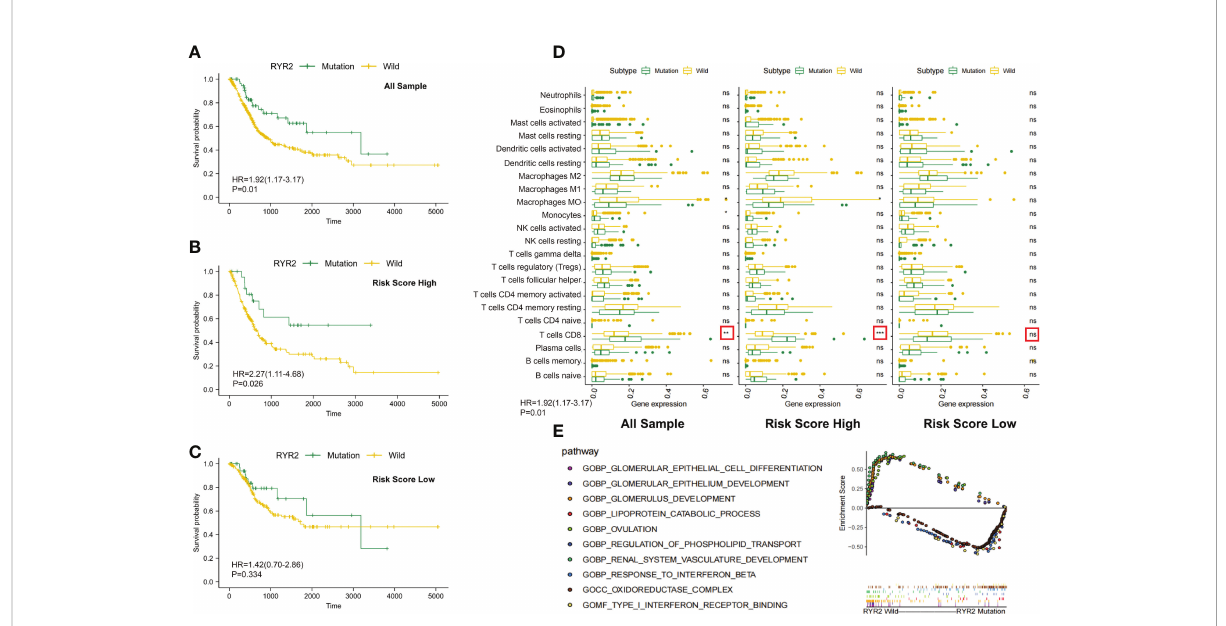
FIGURE 6 Changes between the RYR2 mutation group and the RYR2 wild group. (A-C) Kaplan – Meier curves show the independent relevance between the overall survival time and RYR2 mutation in the DCRSL group (n = 202), DCRSH group (n = 200), and all cohorts (n = 402). (D) Effect of RYR2 mutation on tumor immune cell in fi ltrating in the DCRSL group (n = 202), DCRSH group (n = 200), and whole samples (n = 402) (p-value, *< 0.05, **< 0.01, ns > 0.05). (E) Gene set enrichment analysis comparing the RYR2 phenotype between the mutation group and the wild-type